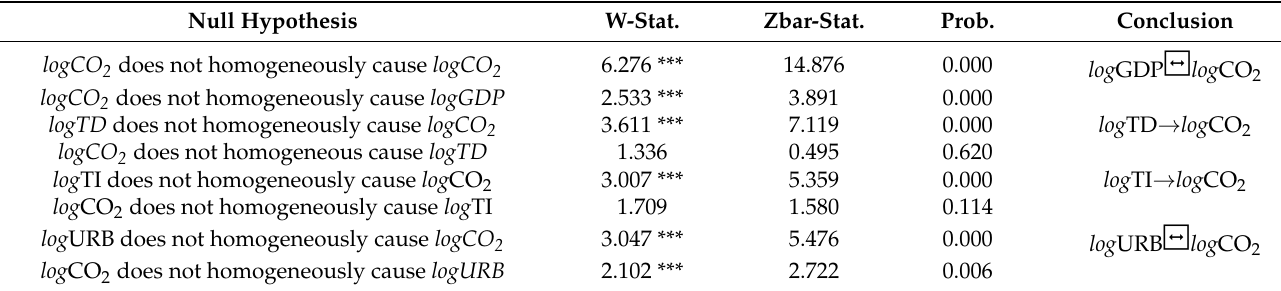
Table 10. Dumitrescu–Hurlin panel causality results.